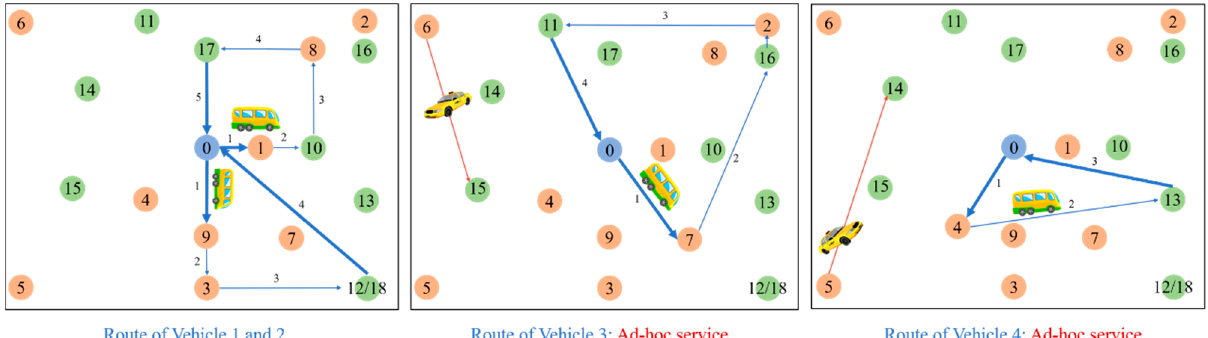
Figure 4. Results of FB with ad hoc service.